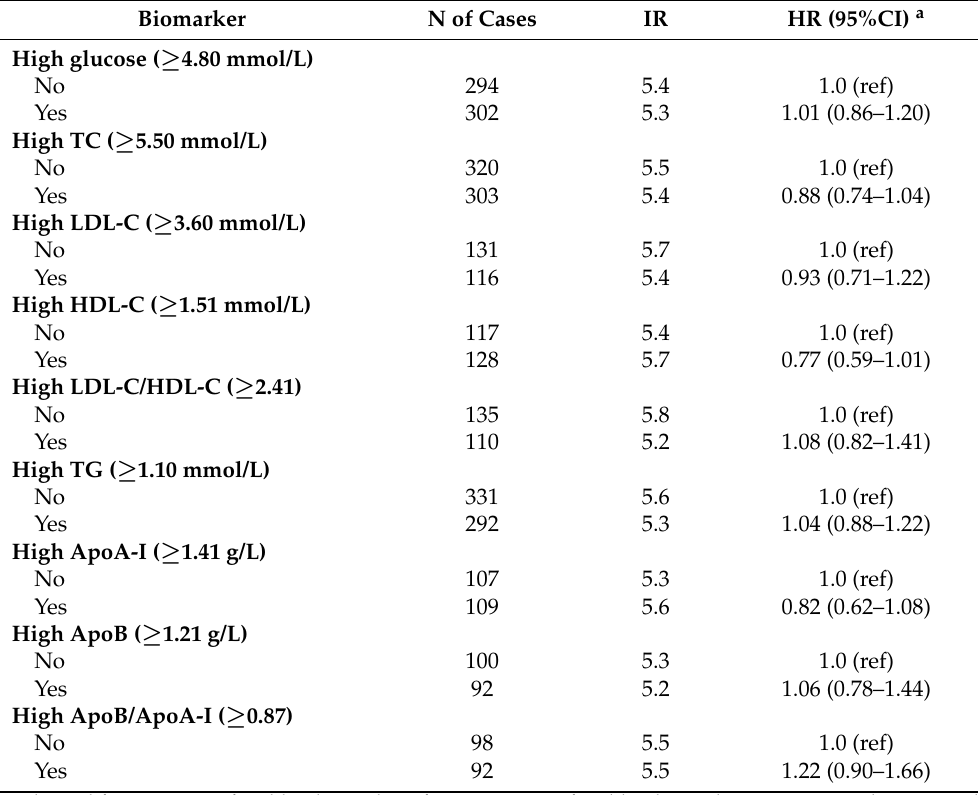
Table 4. Incidence rate (IR) per 100,000 person-years and hazard ratio (HR) with 95% confidence interval (CI) of thyroid cancer in relation to high versus low levels of blood lipid, carbohydrate, and apolipoprotein biomarkers. Biomarker N of Cases IR HR (95%CI) a High glucose ( ≥ 4.80 mmol/L) No 294 5.4 1.0 (ref) Yes 302 5.3 1.01 (0.86–1.20) High TC ( ≥ 5.50 mmol/L)